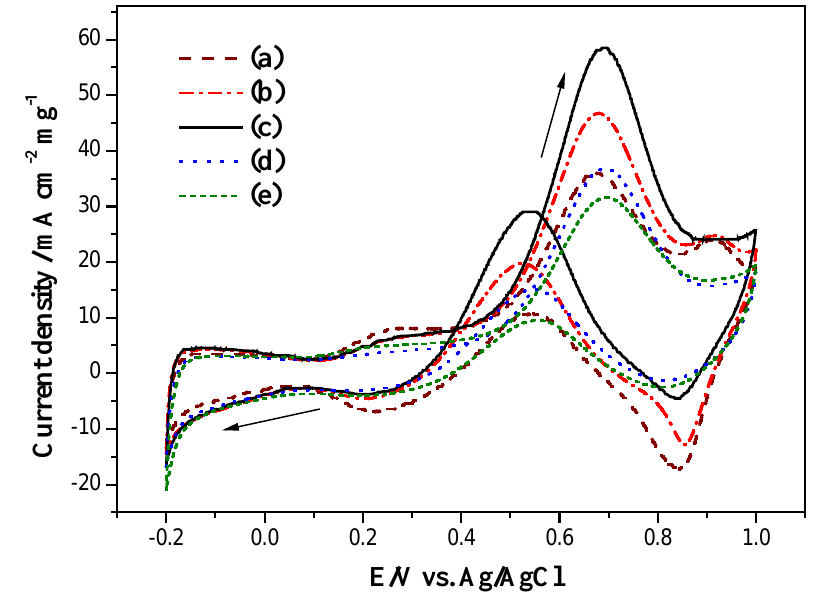
Figure 9. Cyclic voltammograms of ( a ) PICA-Pt; (b ) P(ICA4- co -EDOT1)-Pt; ( c ) P(ICA3- co -EDOT2)-Pt; ( d ) P(ICA2- co -EDOT3)-Pt; and ( e ) PEDOT-Pt in 0.5 M CH 3 OH + 0.5 M H 2 SO 4 solution; the deposition charge of Pt is 0.20 C, scan rate = 50 mV·s −1